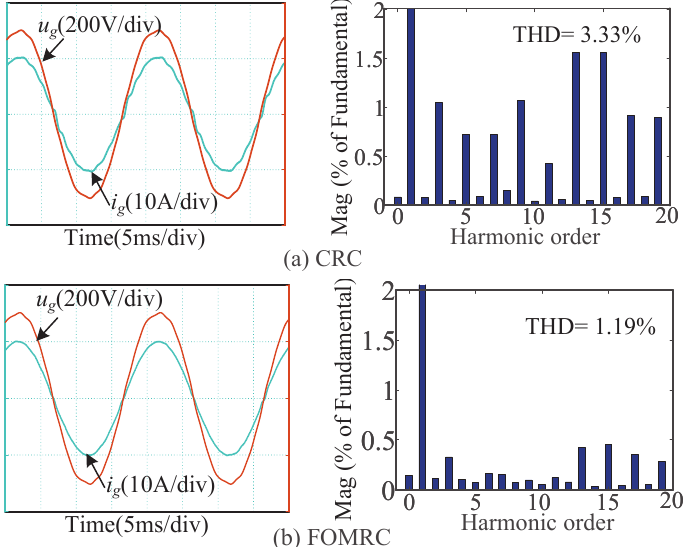
Figure 9. Voltage and current waveforms and current spectrum analysis of the two control systems at the fractional delay ( f g = 49.6 Hz).